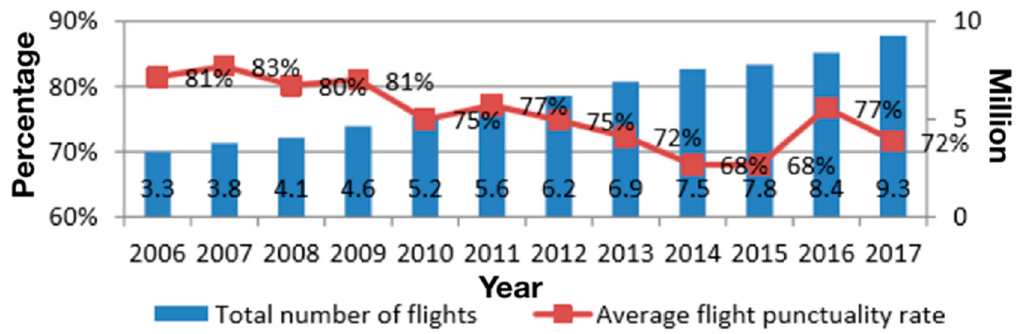
Figure 1. Average flight punctuality rate and total number of flights.